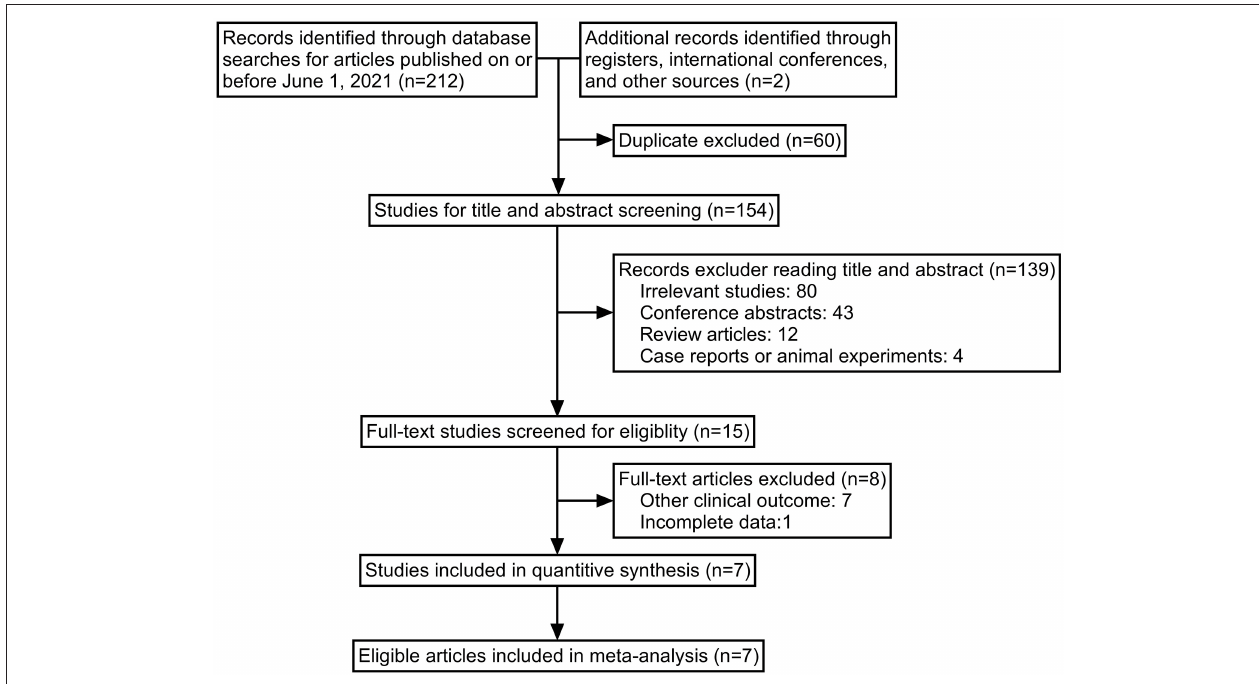
FIGURE 1 | Flow diagram of the study selection process.